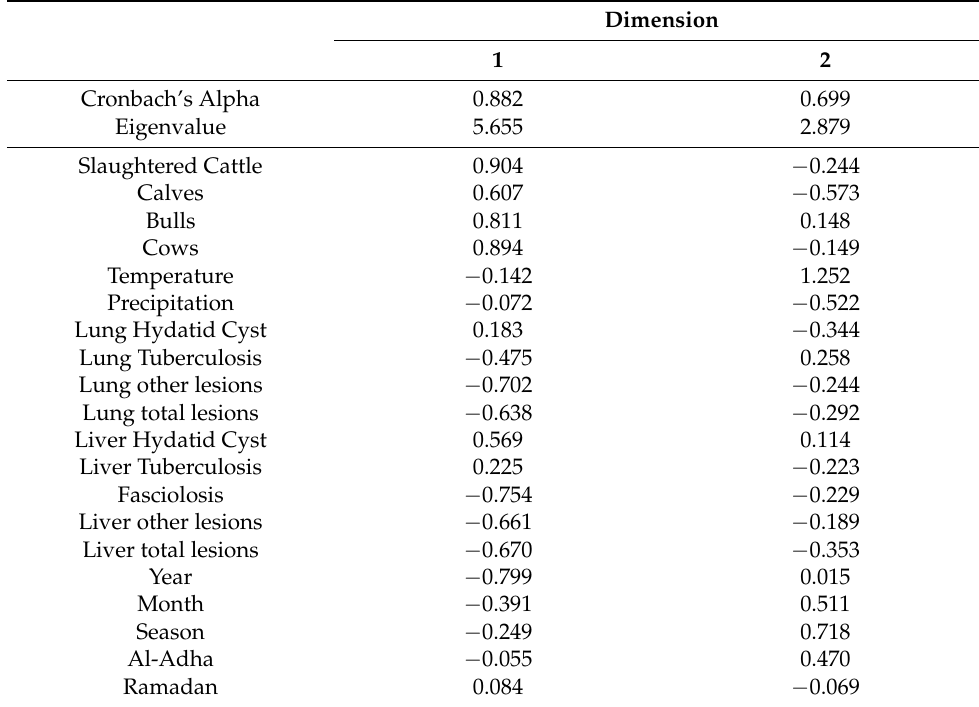
Figure 10. Component loadings plot for the first two components from Principal Components Analysis for Categorical Data (CATPCA). Table 4. Dimensions pattern of normalized variables affecting dynamics of liver and lung lesions using CATPCA.